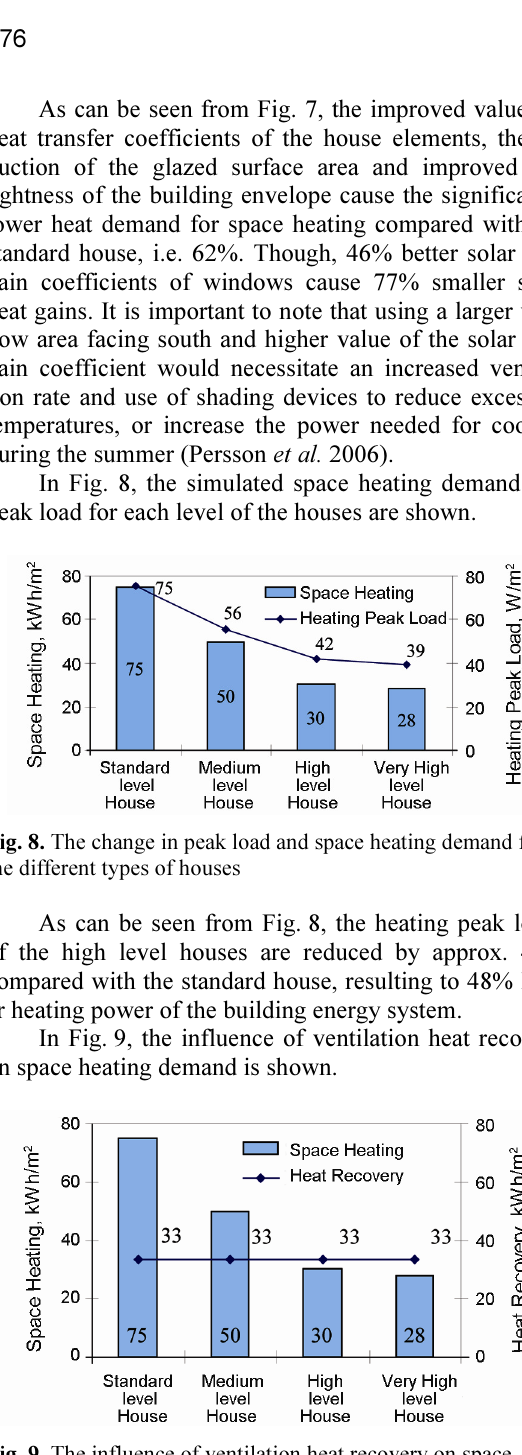
Fig. 9. The influence of ventilation heat recovery on space heating demand